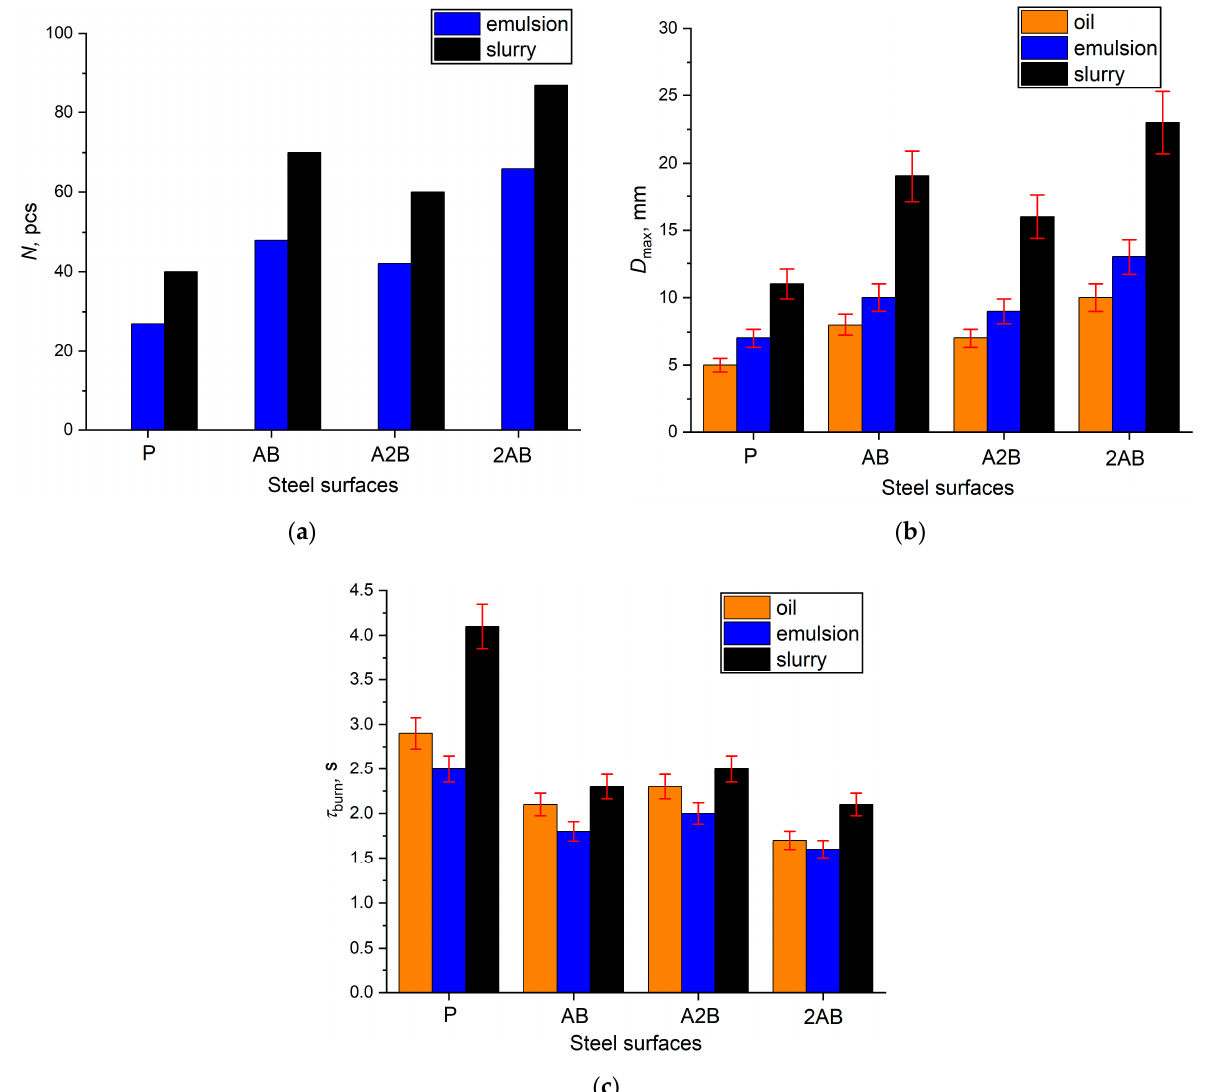
Figure 8. The number of puffing initiations ( a ), the maximum size of the burnout region ( b ), and the time of complete burnout ( c ) of liquid fuels under a mixed heat supply.